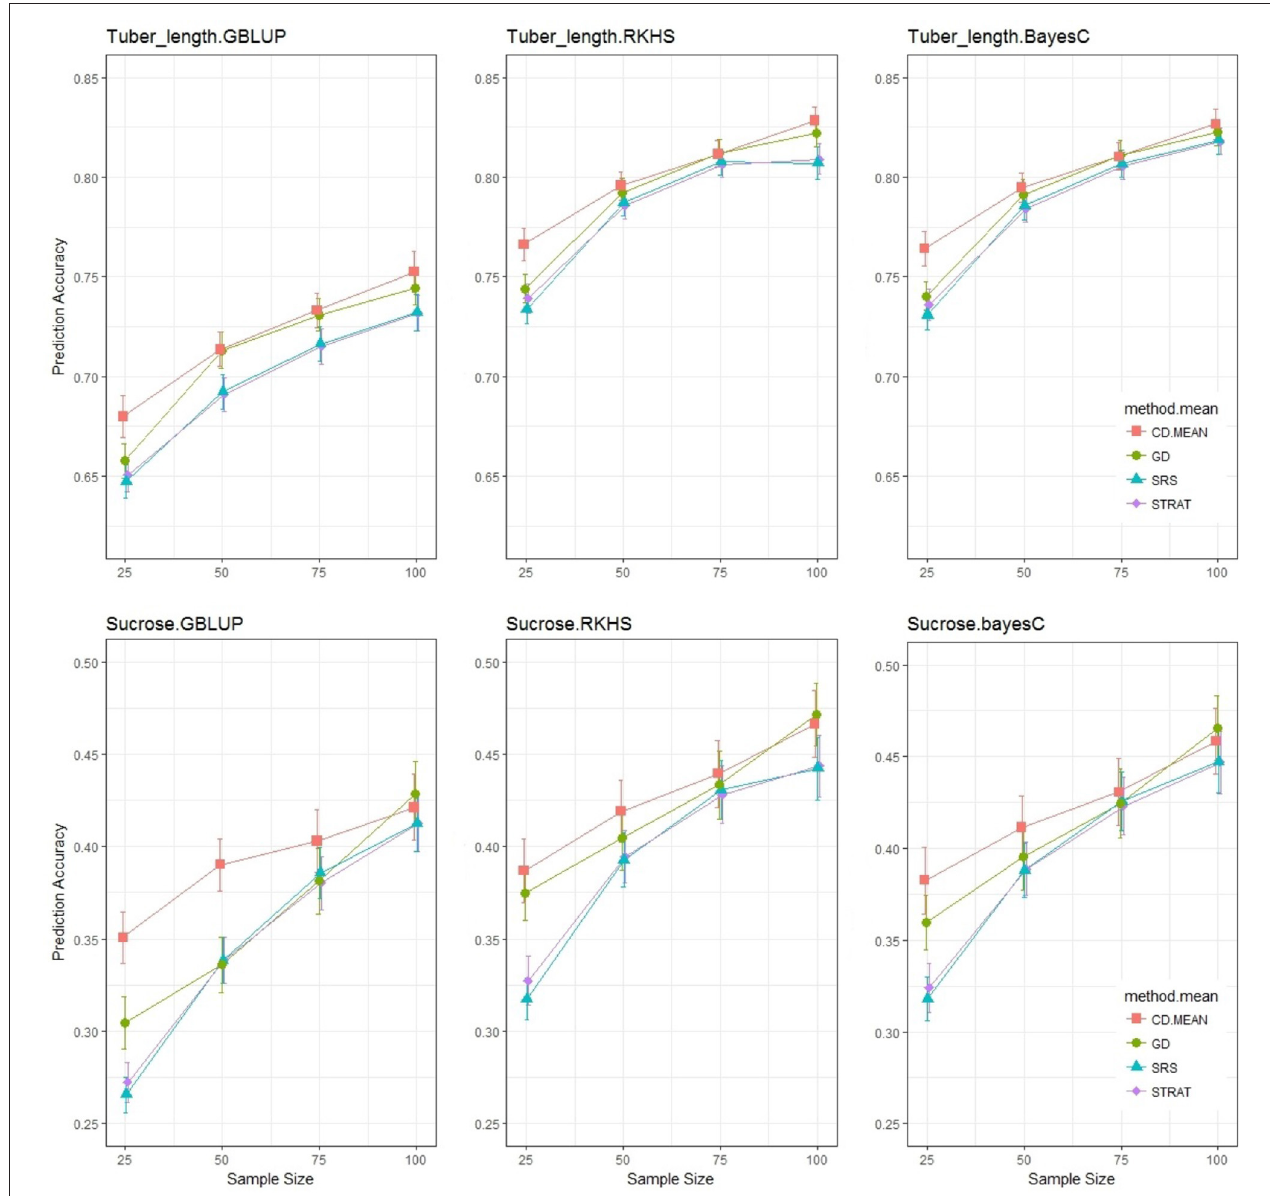
FIGURE 6 | Prediction Accuracy for tuber length and sucrose content with a test set of size 40. Each graphical window represents a different trait-statistical model combination, with varying sample sizes on the x -axis and prediction accuracy on the y -axis. The different colored lines represent different training set sampling